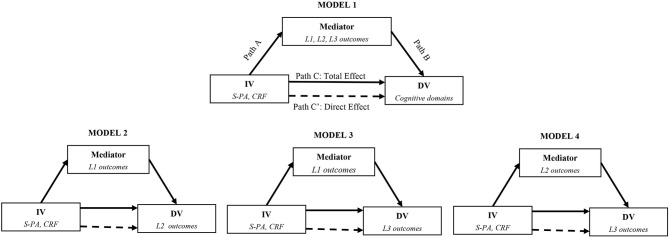
Mediating models.